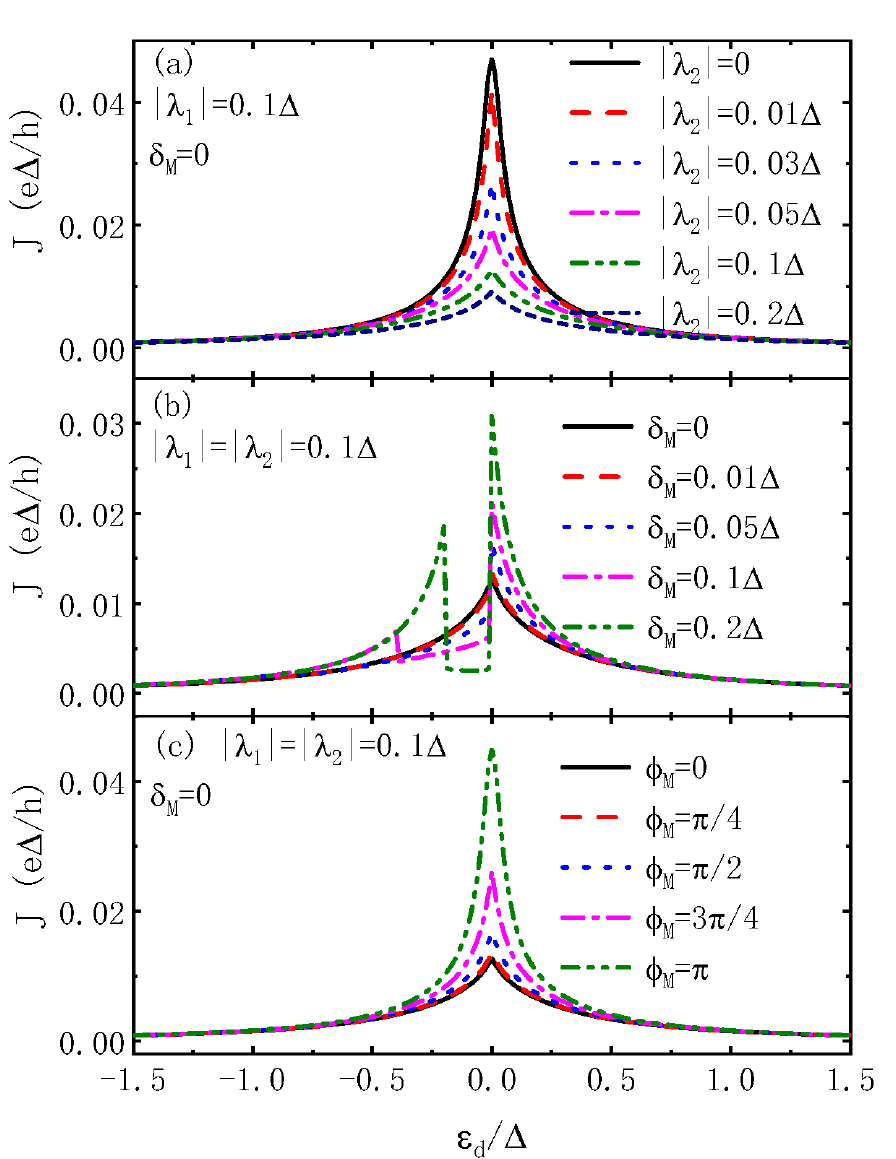
Figure 5. (Color online) Josephson current as a function of the dot level ε d for varying | λ 2 | in ( a ), different δ M in ( b ) and different φ M in ( c ). Other parameters are as in Figure